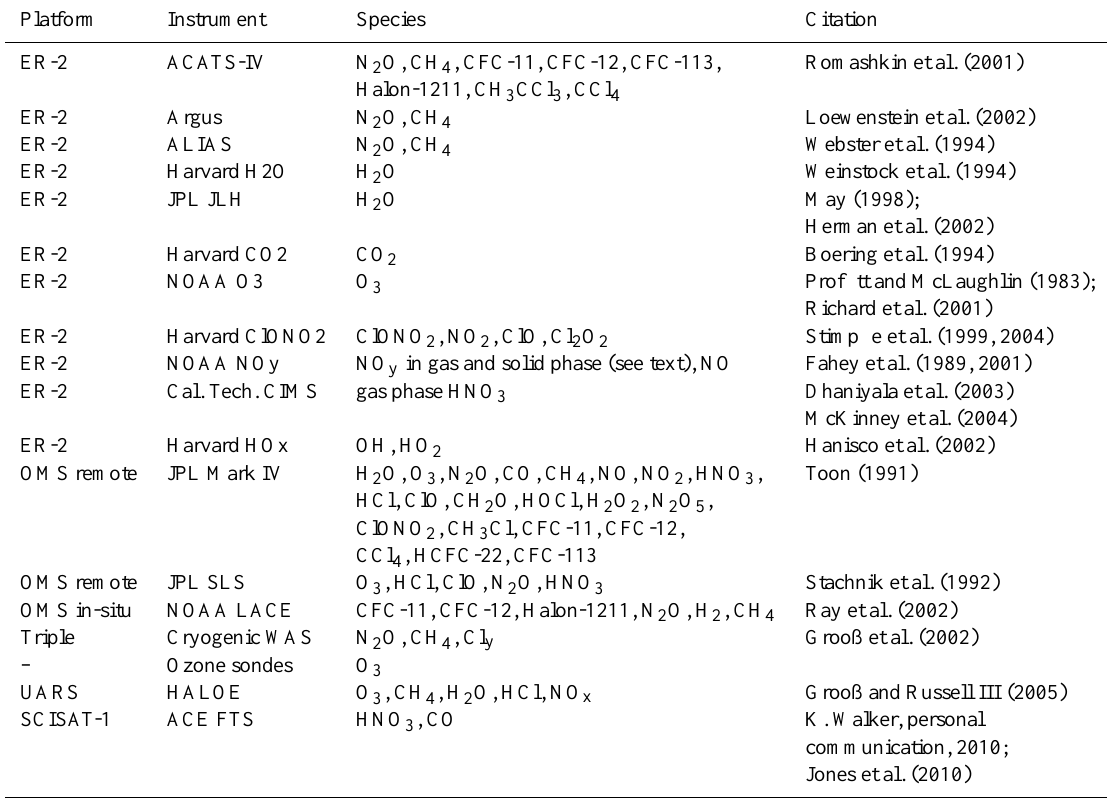
Table 5. Measurements used for initialization and